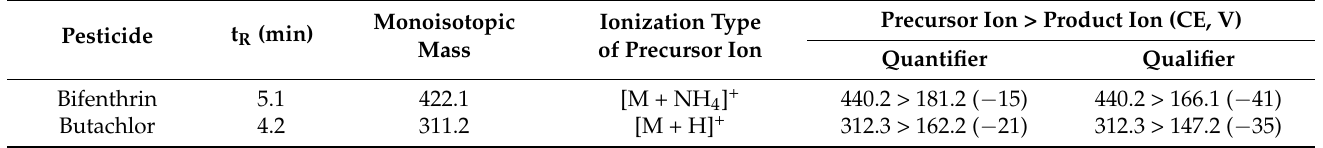
Table 1. Retention times (t R ), MRM conditions, and their collision energies (CEs) of bifenthrin and butachlor used for